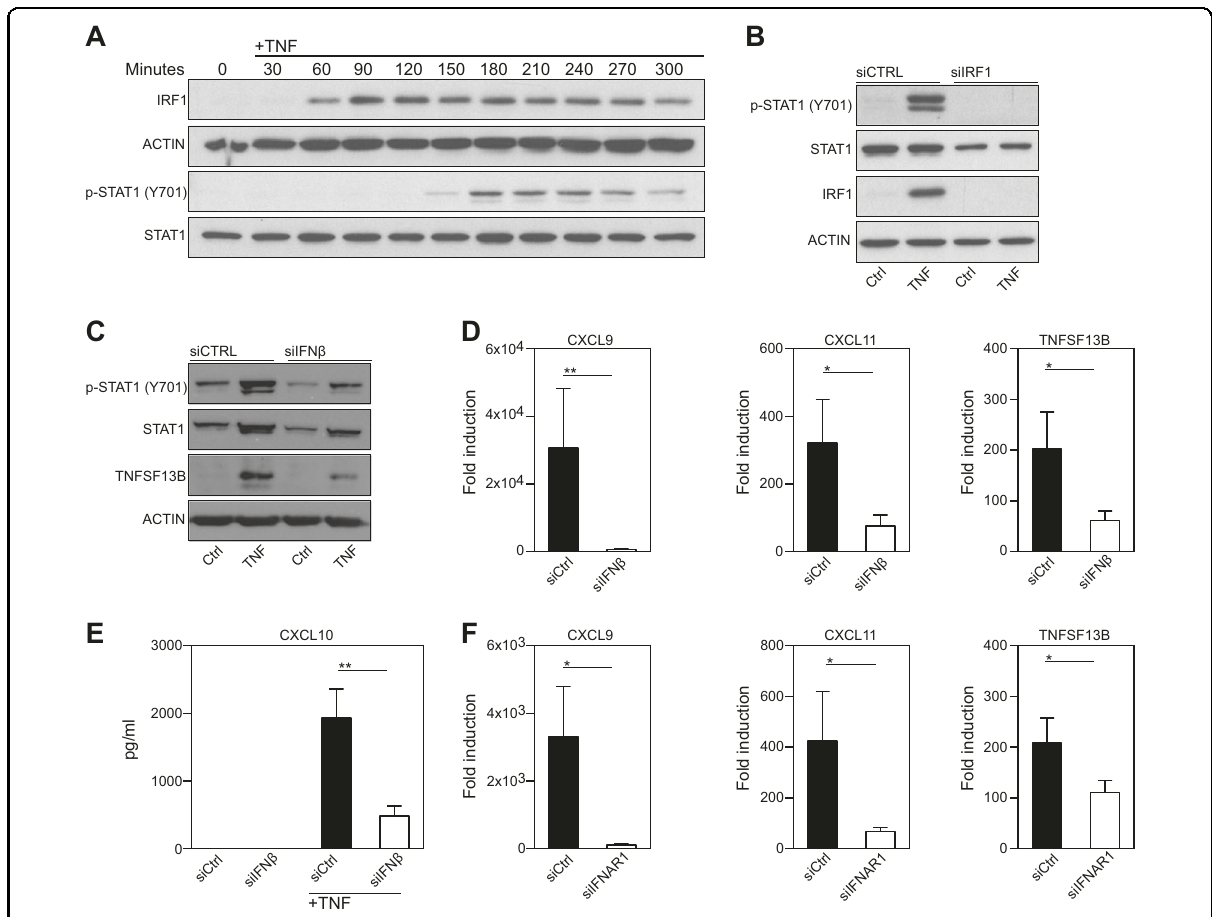
Fig. 4 The TNF-induced interferon response in FLSs depends on IRF1. a Western blot analysis of IRF1 expression and STAT1 phosphorylation in TNF-stimulated (10 ng/ml) FLSs. Blots representative of three independent experiments with different RA-FLS cell lines are shown. b Western blots showing the IRF1 expression and STAT1 phosphorylation in TNF-treated (10 ng/ml; 3 h) RA-FLSs that were transfected with either nontargeting or IRF1-targeting siRNA pools. Blots representative of three independent experiments with FLSs from different RA donors are shown. c – e FLSs were transfected with nontargeting (siCTRL) or IFN β -targeting siRNA pools and then stimulated with TNF (10 ng/ml). c Transfected FLSs stimulated with TNF for 24 h. Western blots representative of at least four experiments performed with different RA-FLS cell lines are shown. d Transfected FLSs from seven donors with RA treated with TNF (10 ng/ml) for 6 h. Gene expression was determined by qPCR. Expression in the treated cells is presented relative to that in the unstimulated cells. Values are shown as the mean ± SEM. * p < 0.05, ** p < 0.01; Wilcoxon matched-pairs test. e Transfected RA- FLSs from seven different donors suffering from RA treated with TNF (10 ng/ml) for 24 h. Supernatants were analyzed for CXCL10 expression by ELISA. Values are shown as the mean ± SEM. ** p < 0.01, Wilcoxon matched-pairs test. f FLSs ( n = 6) transfected with nontargeting (siCTRL) or IFNAR1- targeting siRNA pools and then stimulated with TNF for 6 h. Gene expression was determined by qPCR. Expression in the treated cells is presented relative to that in the unstimulated cells. Values are shown as the mean ± SEM. * p < 0.05, Wilcoxon matched-pairs test. Western blots representative of at least four experiments with different RA-FLS cell lines are